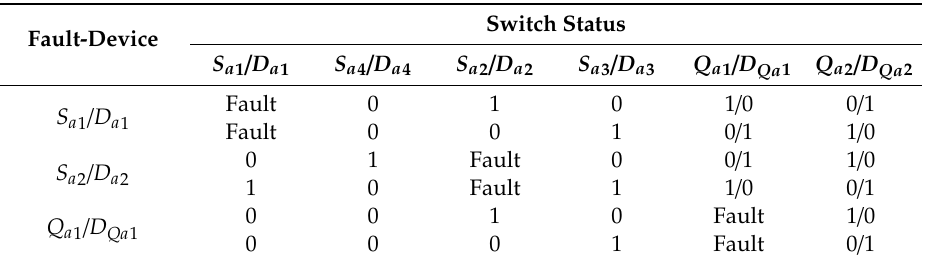
Table 2. Proposed switching sequence at open-circuit fault